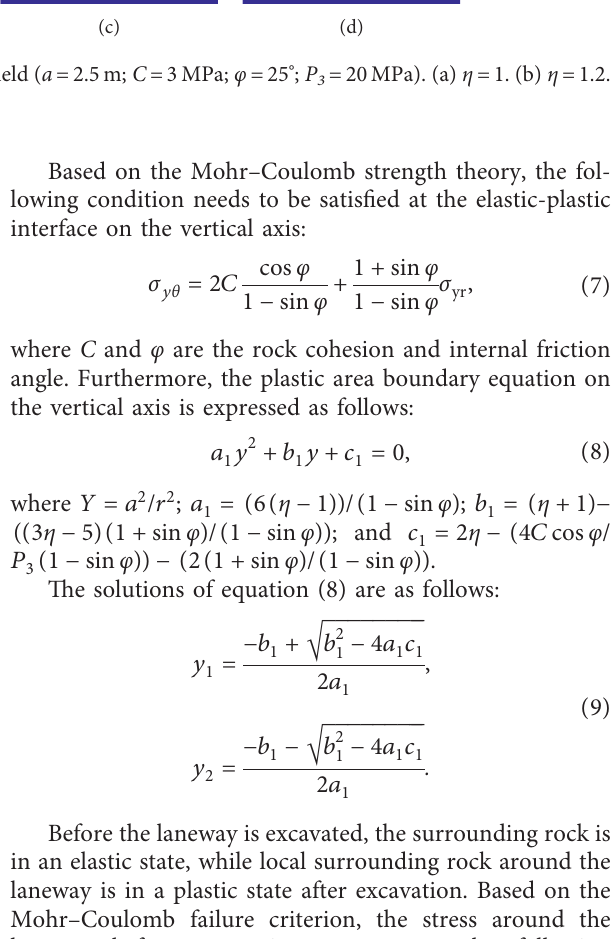
� 20MPa). (a) η � 1. (b) η � 1.2. 3